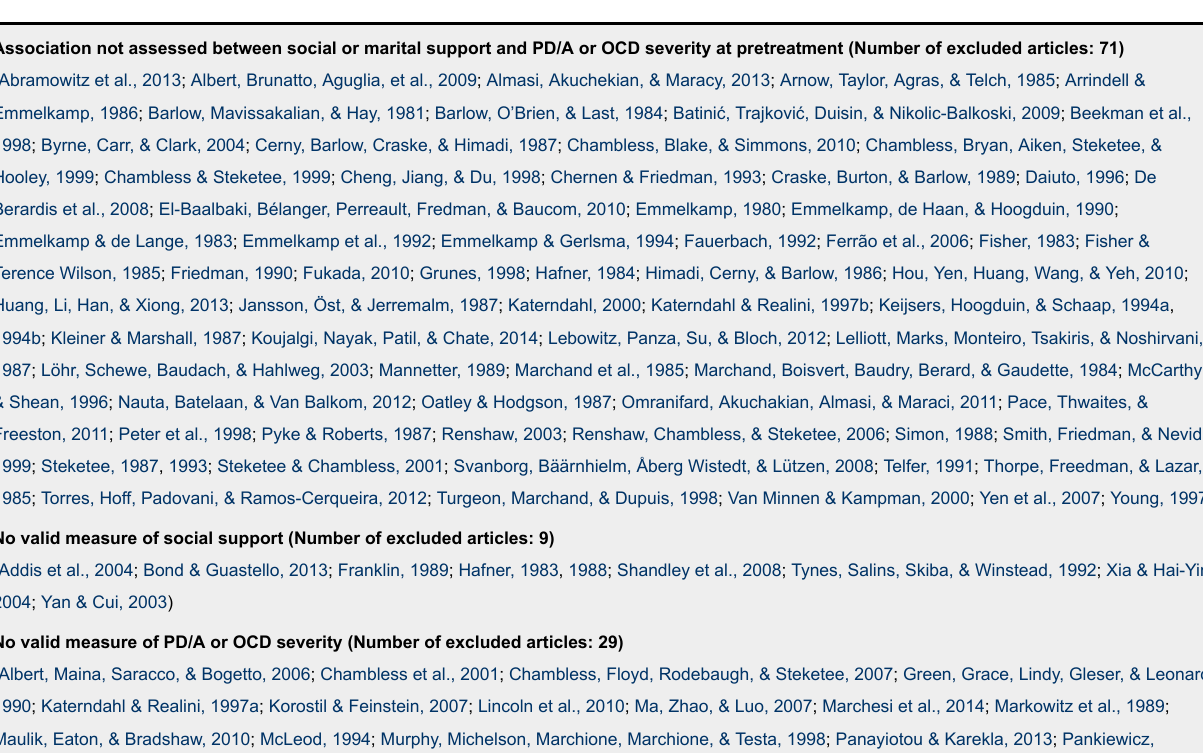
Reasons for Exclusion of 143 Articles After Full Text